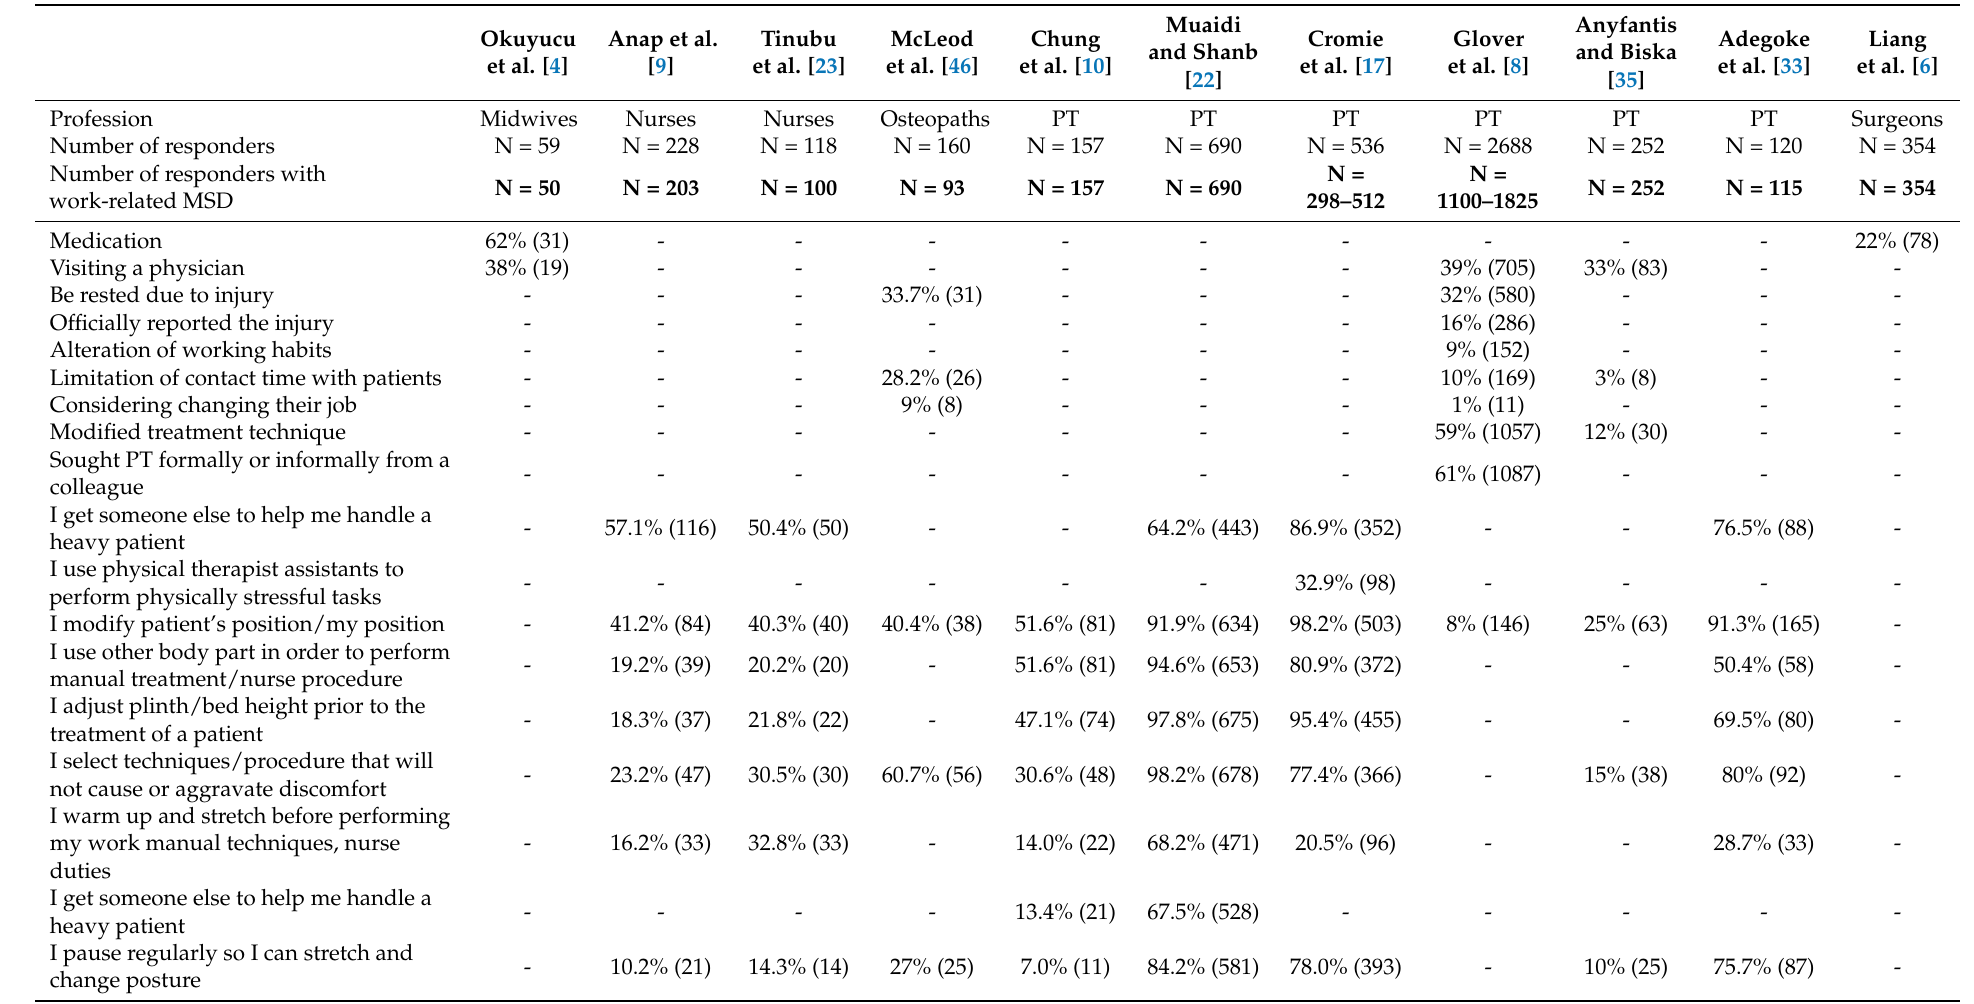
Table A3. Response and treatment used to reduce symptoms of MSD identified for all healthcare professionals (percentage of sample and corresponding number of participants in